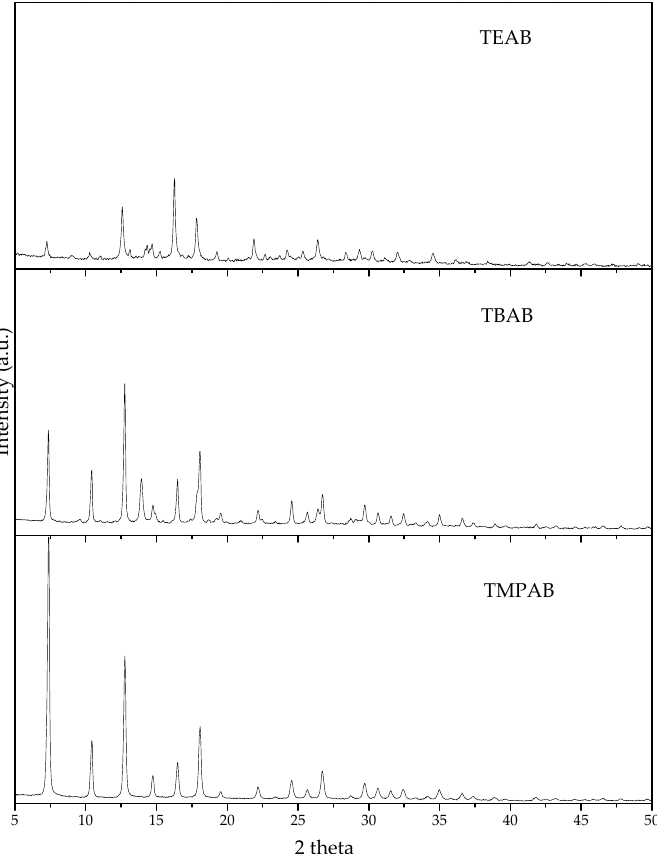
Figure 2. XRD patterns of synthesized samples obtained from different quaternary ammonium salts. The ratio between 2-methyl imidazole (2-MeIM) and quaternary ammonium salts (QAS) was 8:2.